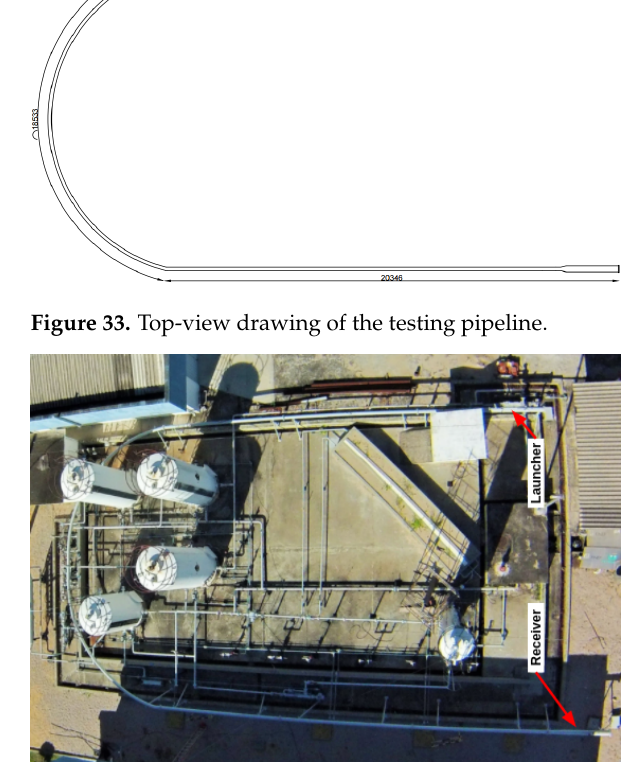
Figure 34. Aerial photo of the testing pipeline.